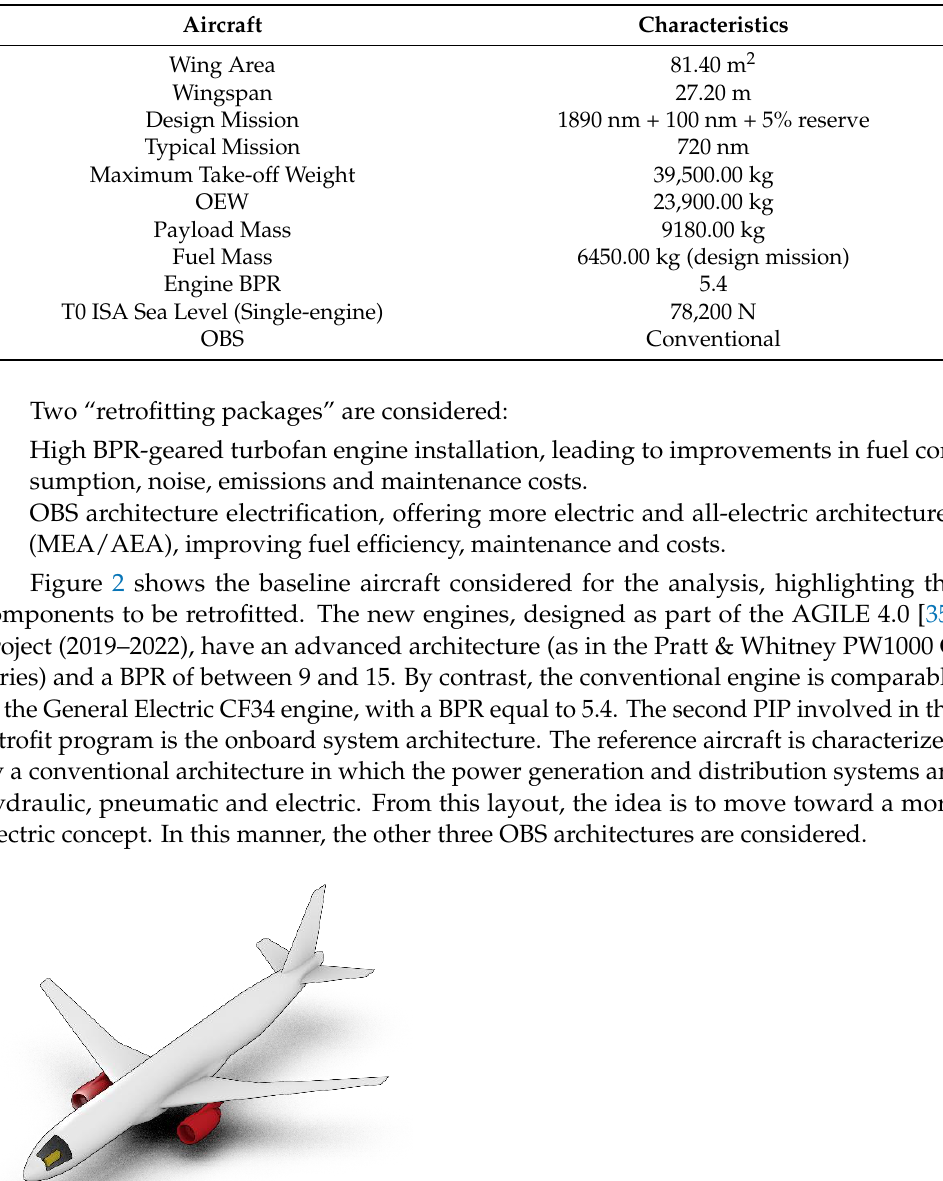
Table 1. The reference regional jet aircraft's main characteristics.